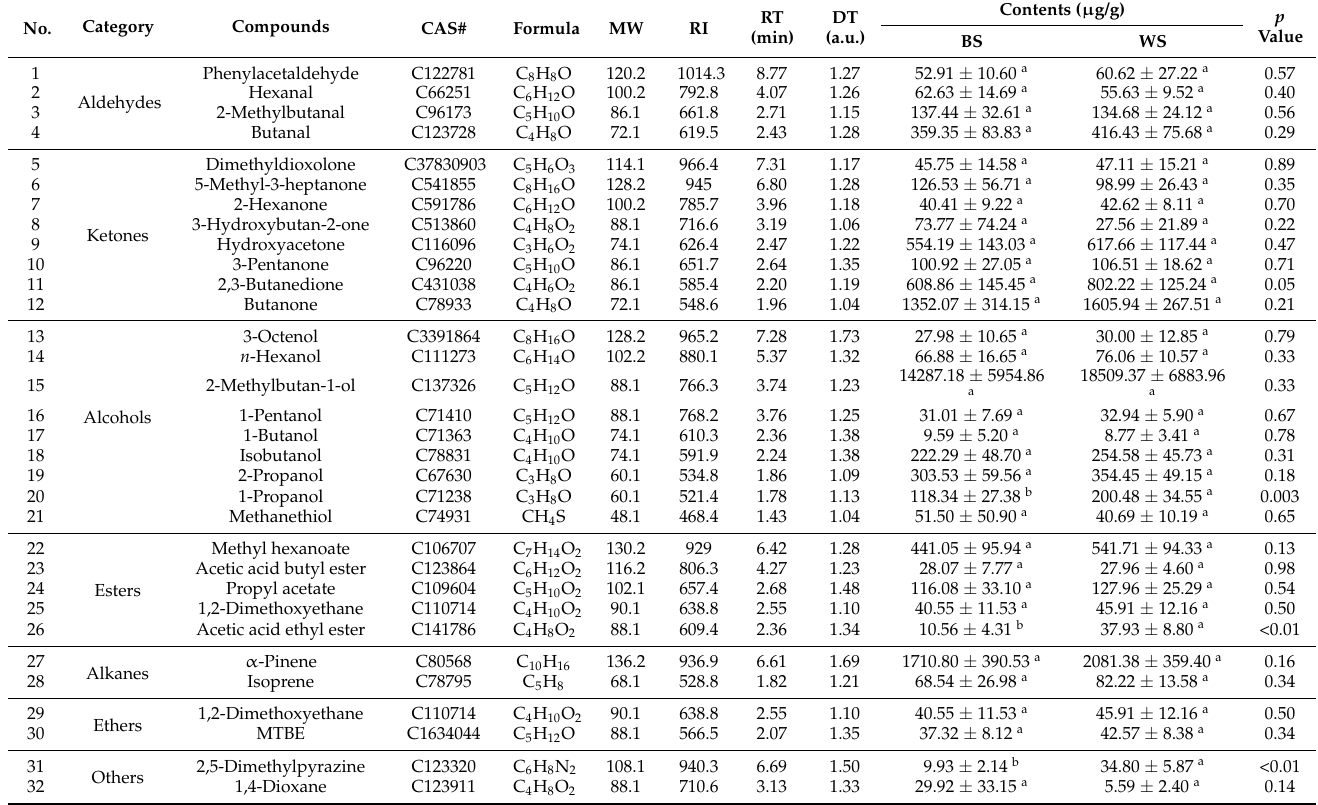
Table 2. Contents and statistical results of the volatile compounds determined in the black and white sesame